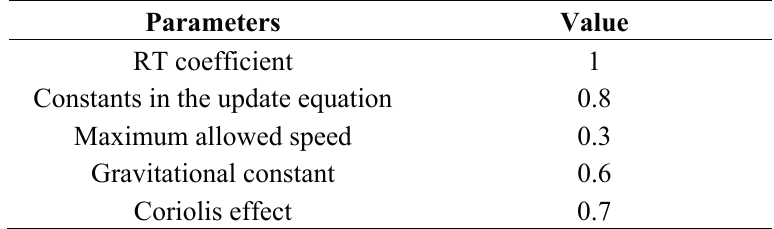
Table 4. The parameters setting of wind driven optimization (WDO).